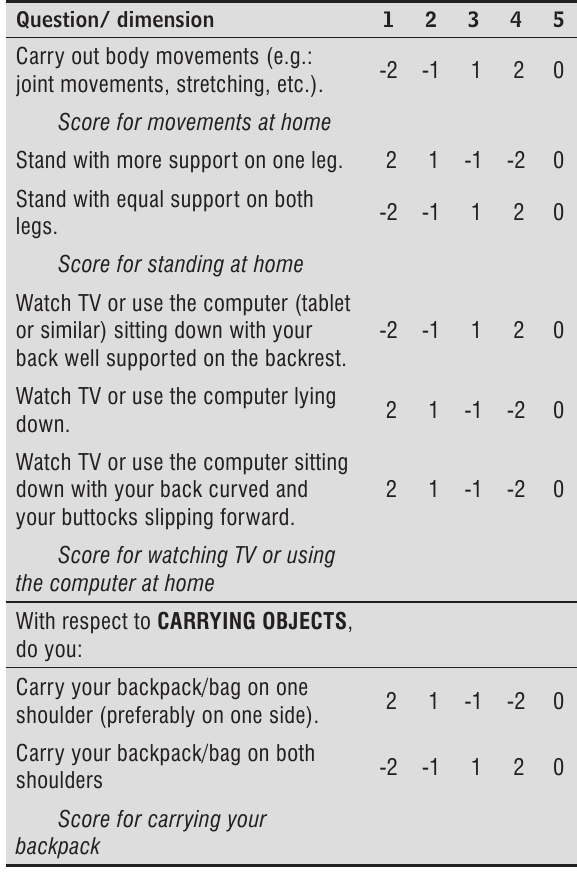
Table 4 - Questionnaire on body awareness and postural habits of young people and the respective values for the